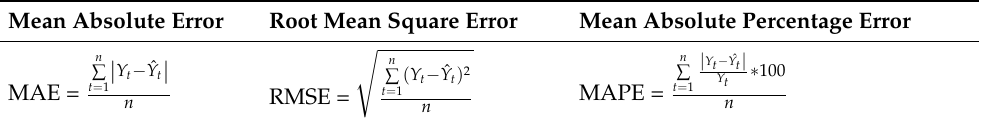
Table 3. Forecast errors metrics. Mean Absolute